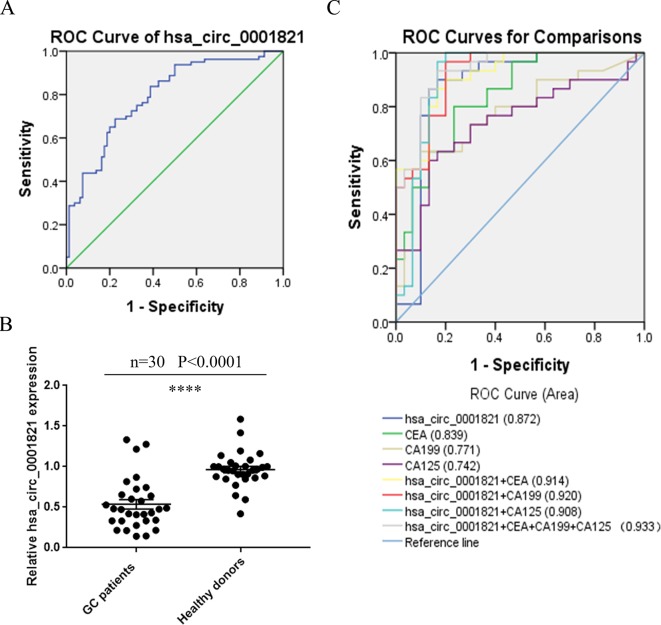
Evaluation of the diagnostic value of hsa_circ_0001821 in gastric cancer (GC) patients. (A) Receiver operating characteristic (ROC) analysis of hsa_circ_0001821 in differentiating GC tissues from noncancerous tissues (n = 80). (B) Detection of circulating hsa_circ_0001821 expression in the whole-blood samples from GC patients (n = 30) and healthy donors (n = 30). (C) The construction of the joint diagnostic model containing circulating hsa_circ_0001821 and existing laboratory indicators. ****P<0.0001 was considered significant.